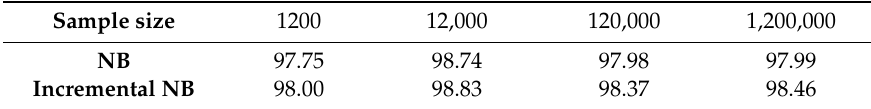
Figure 10. Comparison of original naïve Bayesian (NB) and incremental NB. ( a ) Comparison of training time; ( b ) comparison of classification accuracy. Table 4. Classification accuracy comparison Table 3. Training time comparison (MS).